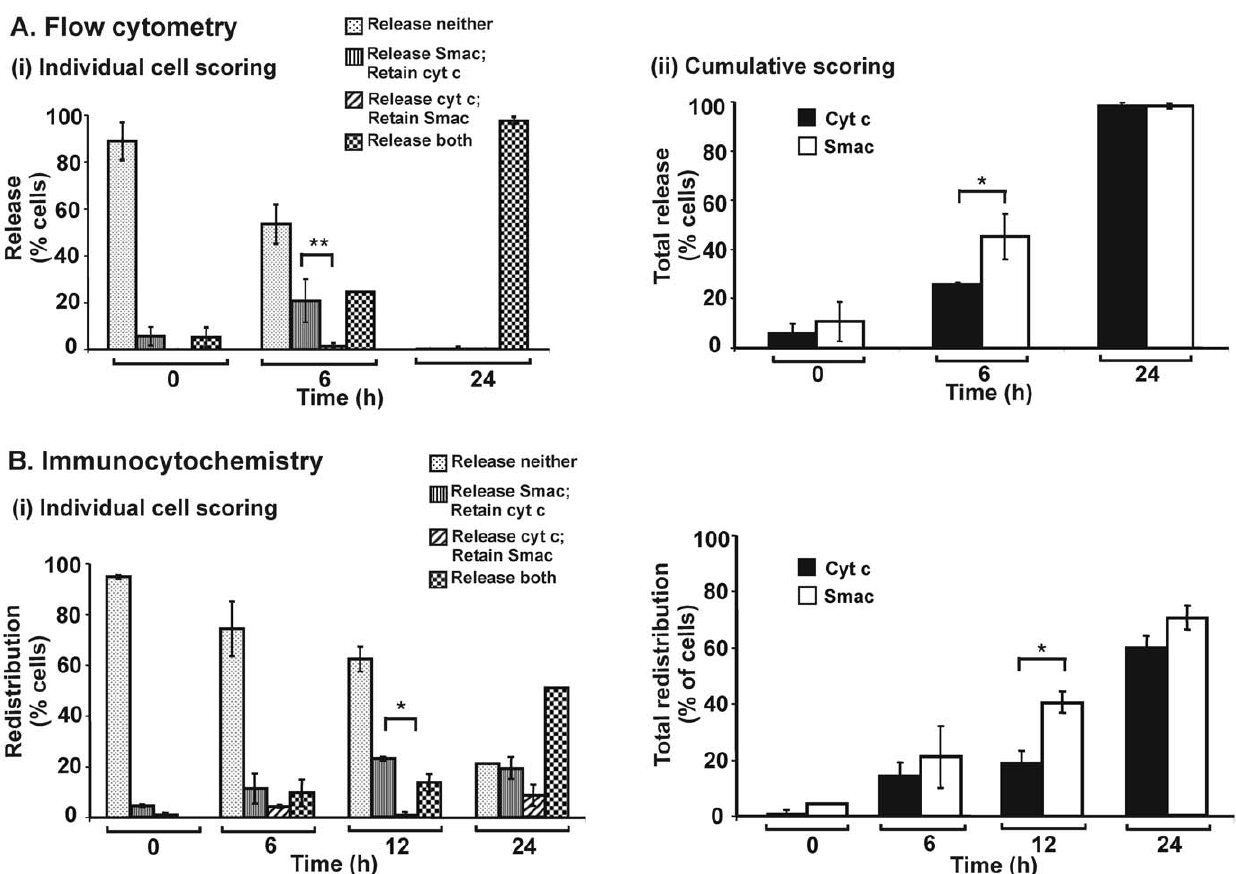
Figure 6. Early redistribution of Smac relative to cyt c in 143B cells treated with MT-21. 143B cells were untreated or treated with MT-21 (200 m M) for various times. All other indications as for Figure